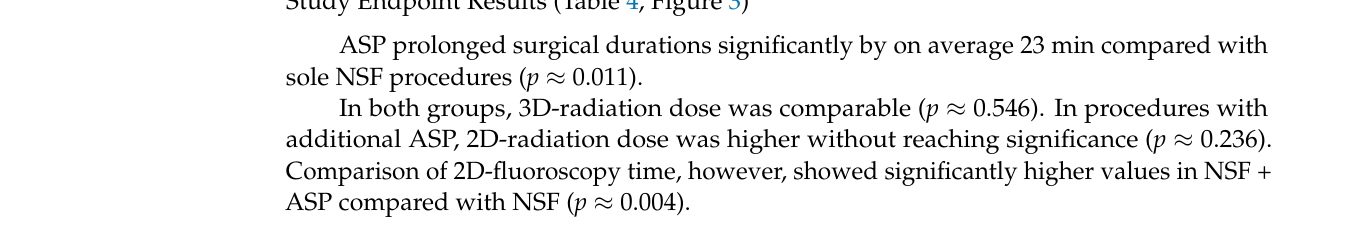
Table 4. Summary of results. Differences between groups were significant as to surgical time, fluoroscopy time, implant costs, and reimbursement. Significance was reached at p < 0.05 (